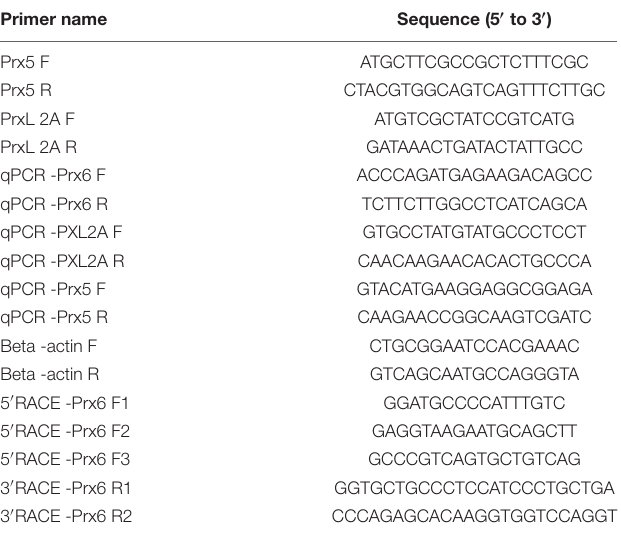
TABLE 1 | Primer names and